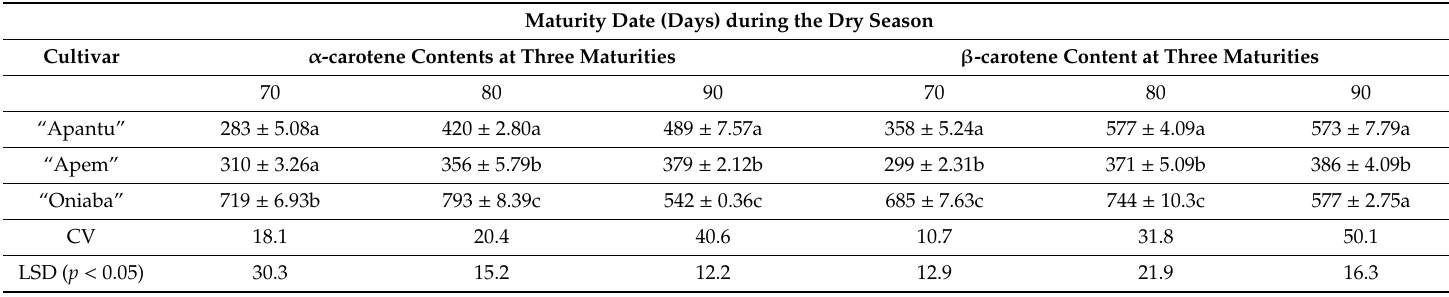
Table 4. Provitamin A active carotenoid levels µ g / 100 g edible pulp of three di ff erent plantain cultivars at maturation and seasonality. Maturity Date (Days) during the Dry